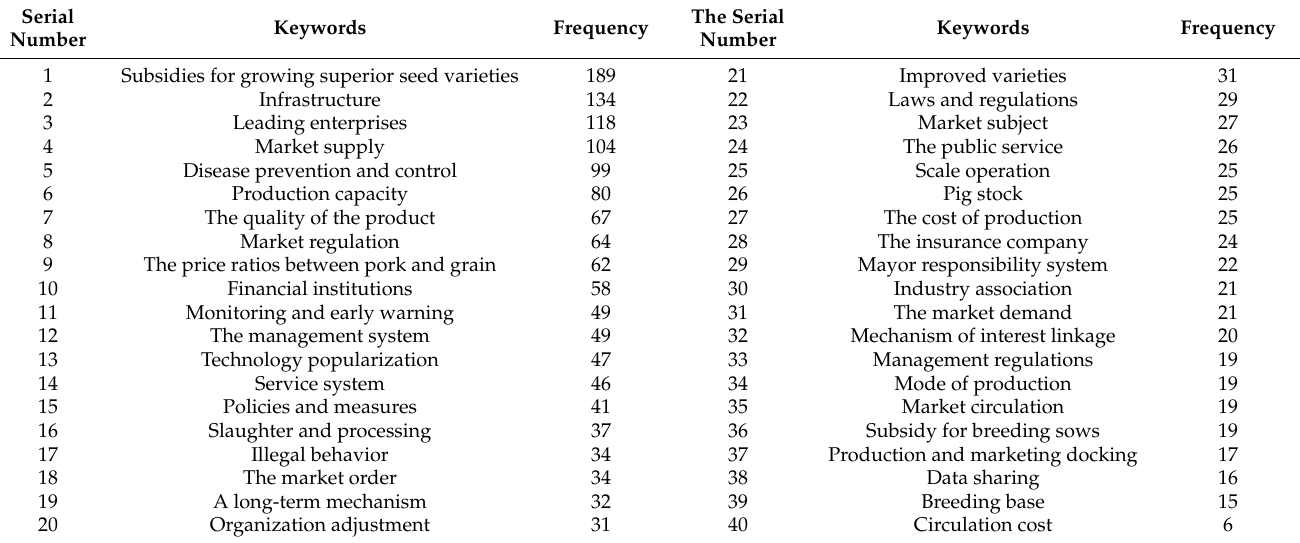
Table 2. China’s pig price regulation policy text key words frequency statistics